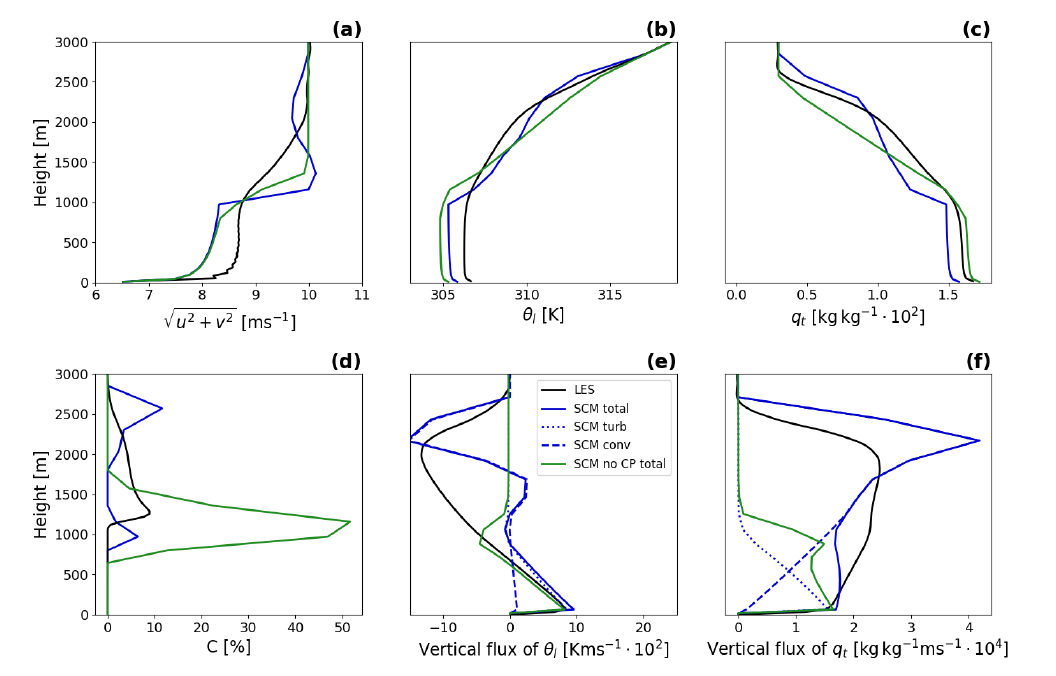
Figure 2. One-hour mean vertical profiles of wind speed ( a ), θ l ( b ), q t ( c ), cloud fraction ( d ), and vertical fluxes of θ l and q t from the turbulence scheme and the convection scheme ( e , f ) for the ARM case after 9 h of integration for LES (MicroHH) and ICON SCM simulations. Results from the ICON SCM simulation with the convection scheme are marked as “SCM total” and without the convection scheme as “SCM no CP total”. In case of “SCM total”, the vertical fluxes from the turbulence scheme are marked as “SCM turb” and from the convection scheme as “SCM